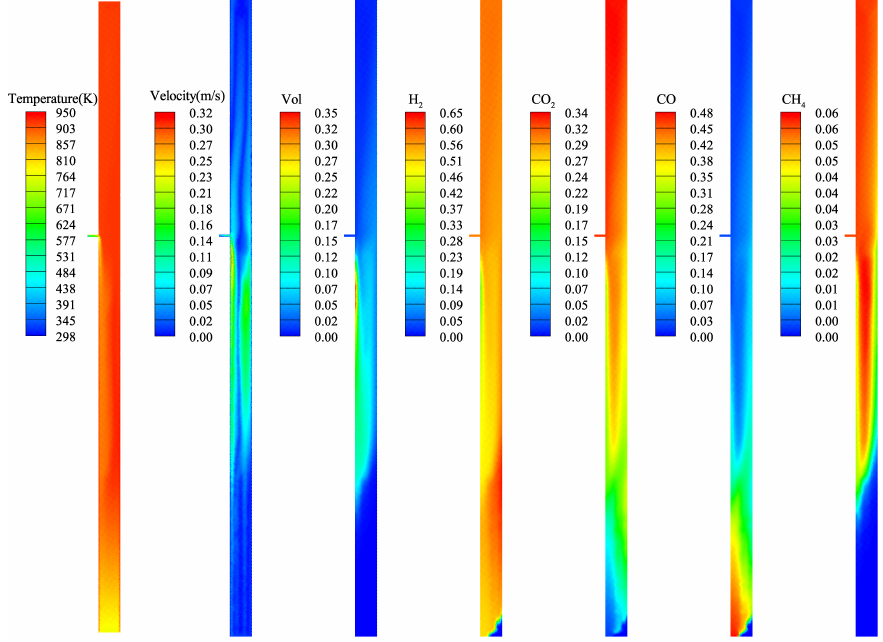
Figure 3. Cross-section plots of the temperature distribution, the velocity field and the mole fraction distributions of gasification products for the studied SCWFB reactor of Case